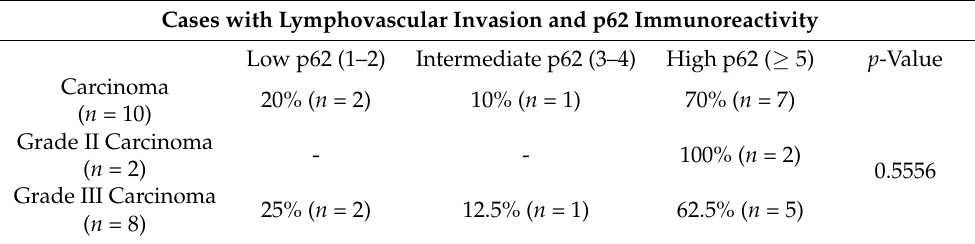
Table 2. Immunoreactivity score for p62 in cases with lymphovascular